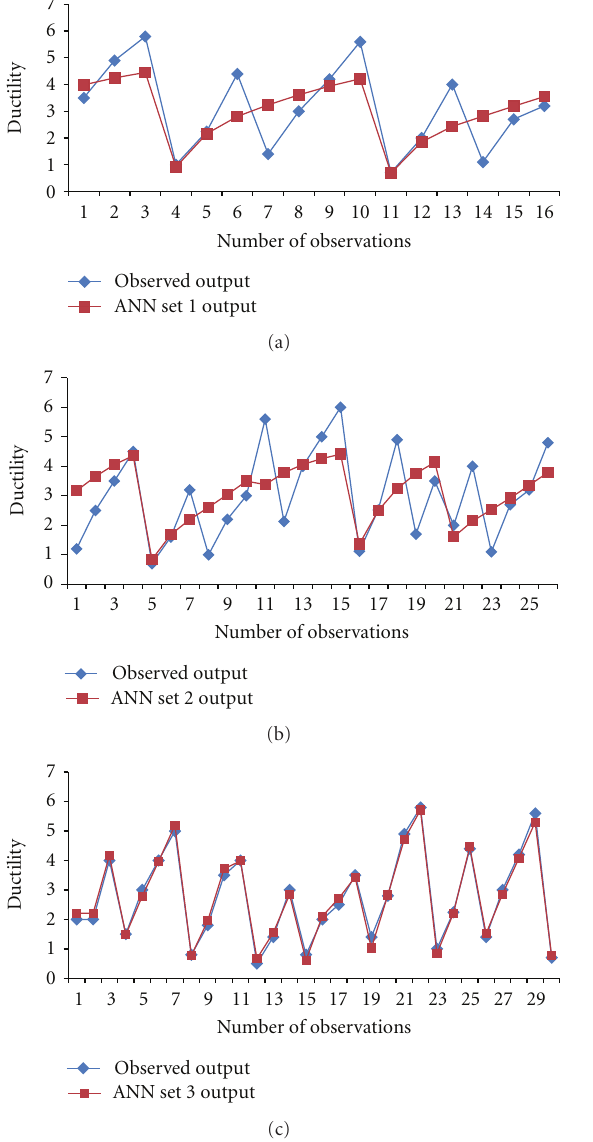
Figure 4: Comparative study of ductility by observed and ANN model for (a) dataset 1, (b) dataset 2, and (c) dataset 3.